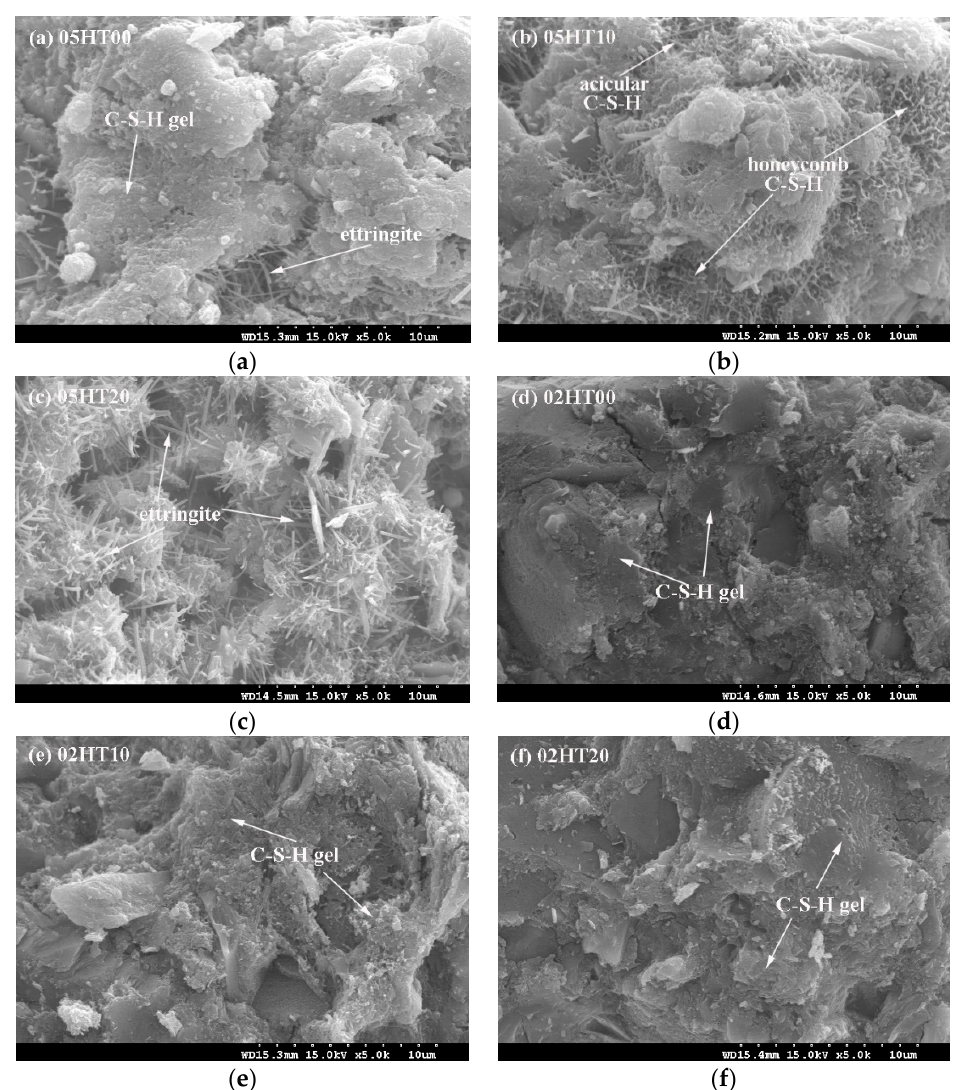
Figure 9. Microstructure images of three-day old pastes. ( a ) 05HT00, ( b ) 05HT10, ( c ) 05HT20, ( d ) 02HT00, ( e ) 02HT10, and ( f ) 02HT20.